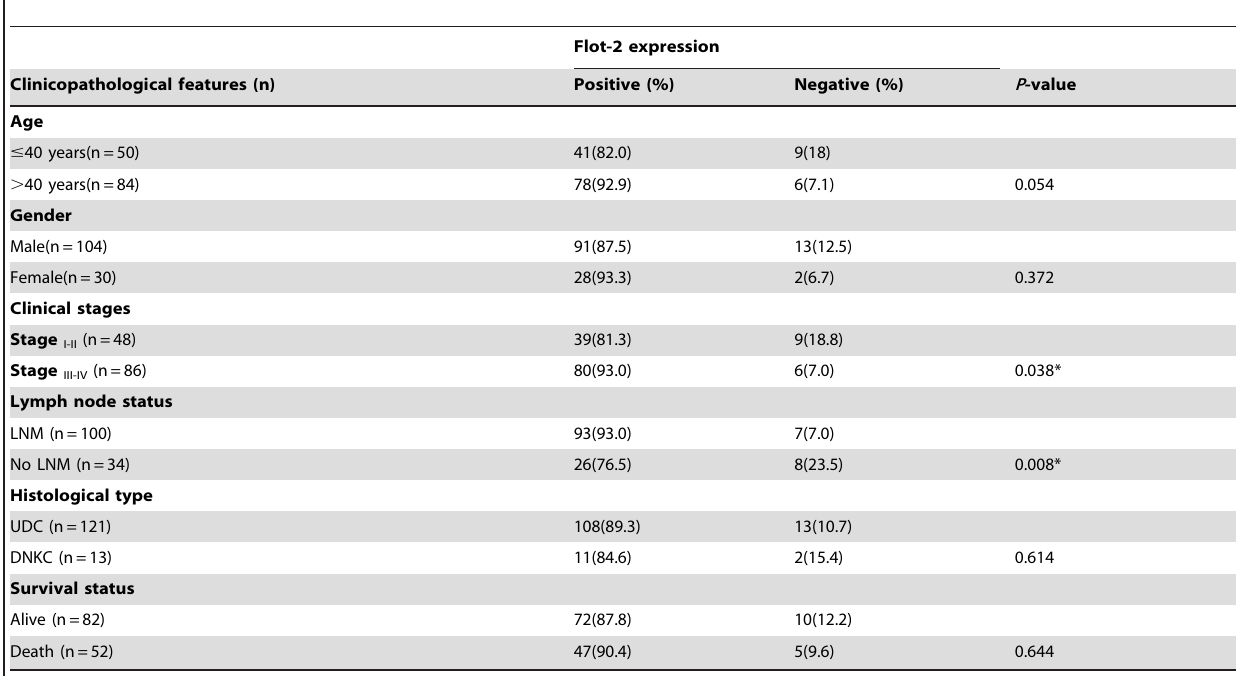
Table 1. Analysis of the association between expression of Flot-2 protein and clinicopathological features of NPC.